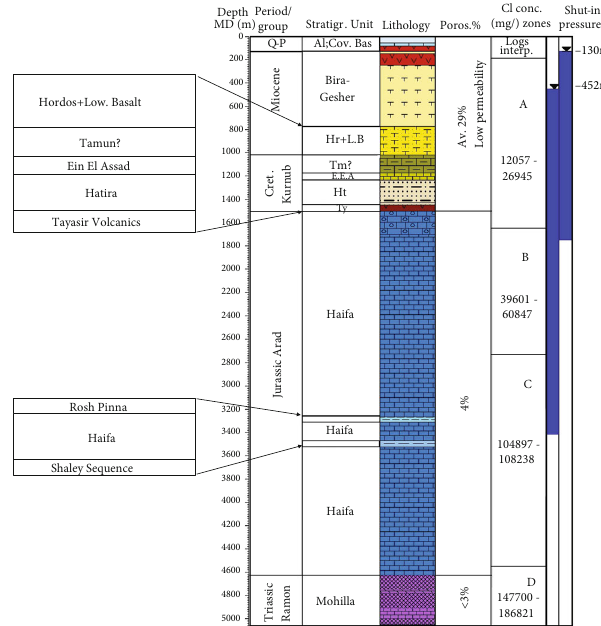
Figure 2: Lithology, porosity, shut-in pressure, and Cl -